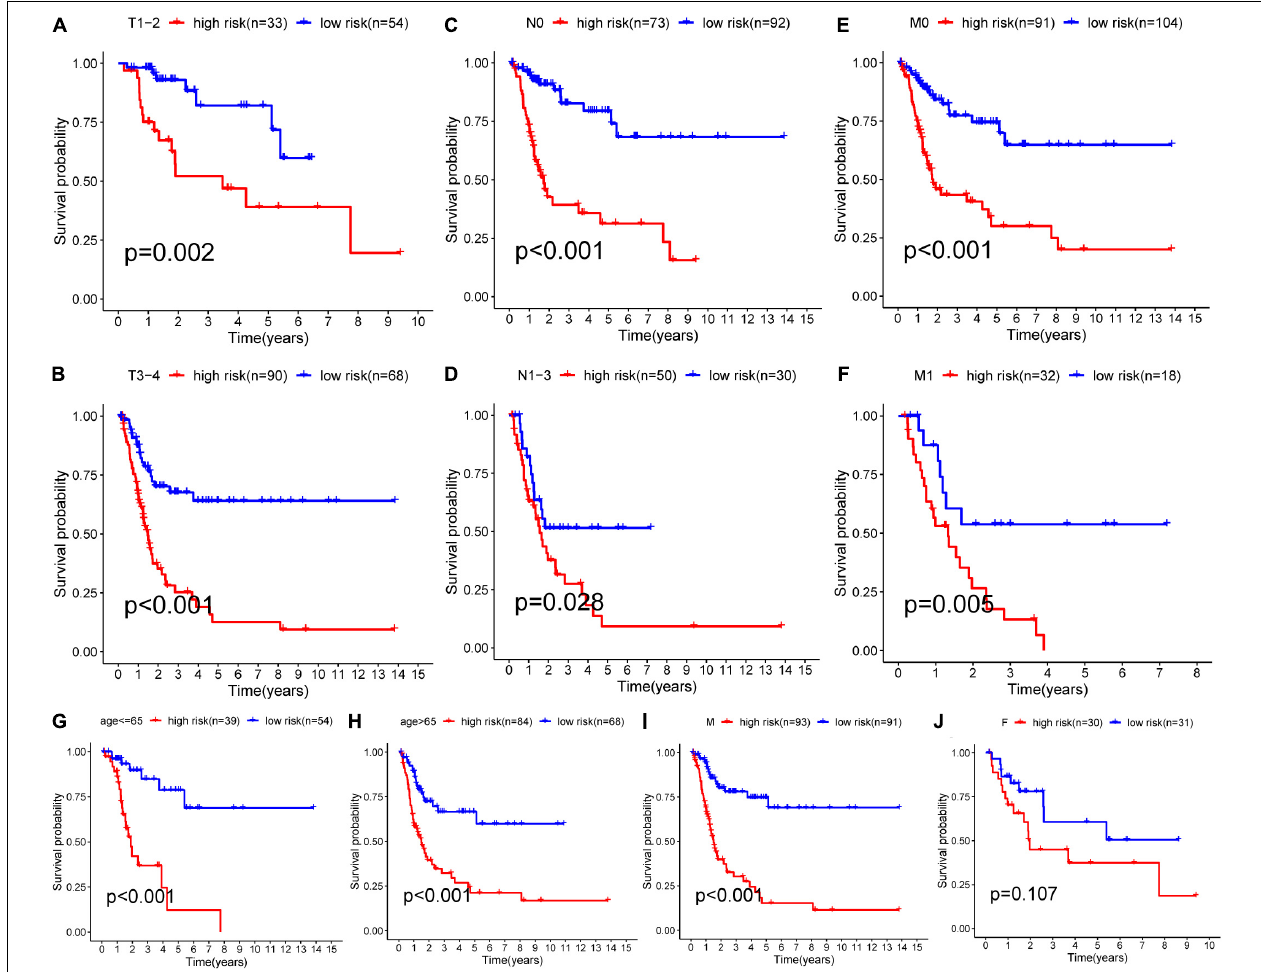
FIGURE 6 | The results of subgroup analysis. Analysis showed that the OS of bladder cancer patients in the high-risk group was significantly lower than that in the low-risk group based on age and TNM stage ( P < 0.05). (A–I) In male patients, the OS in the high-risk group was also significantly shorter than that in the low-risk group ( P < 0.001), while no significant difference was shown in female patients ( P = 0.107) (J) , possibly due to the relatively small number of cases.